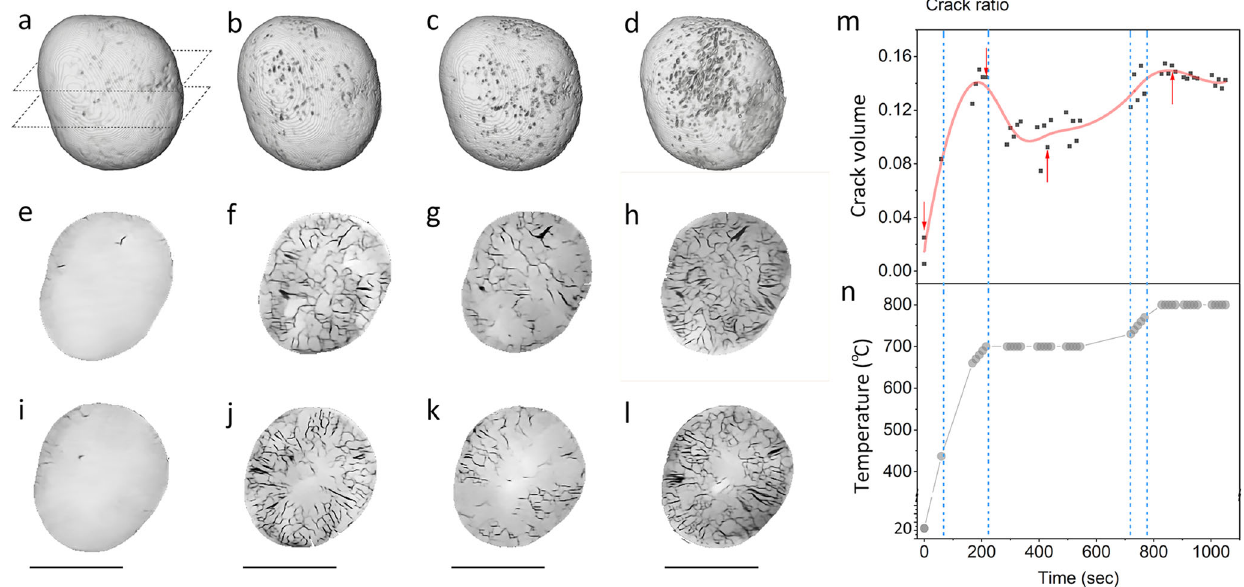
Fig. 5 Structure evolution of LiNi 0.8 Mn 0.1 Co 0.1 O 2 during heating. 3D rendering of particle at temperature: a Room temperature. b Initial reach to 700 o C. c Annealed at 700 o C for 2 min. d 800 o C. e – h Transparent rendering showing the internal cracks at the same temperature as ( a – d ). i – l 2D slice views of the particle at the same temperature as ( a – d ). Scalebar is 5 μ m for ( a – l ). m The extracted volume fraction of cracks at different temperatures. n Temperature pro fi le used in the experiment. Note that there are gaps in the time between each 5 data points, which is due to the time overhead in the scanning scheme. Details can be found in Supplementary Note